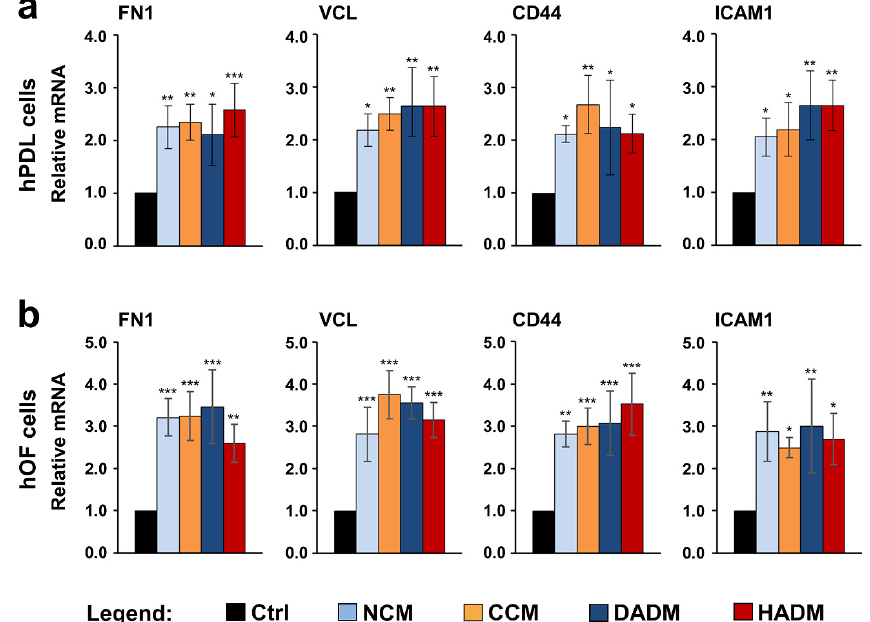
Figure 5. Increased expression of adhesive marker genes in two oral cell types grown on four different collagen matrices. hPDL ( a ) and hOF ( b ) cells were cultured on four different collagen matrices (NCM, CCM, DADM, and HADM) for 9 h followed by an extensive wash for complete removal of nonadherent cells before total RNA was extracted and analyzed for the expression of adhesive marker genes (FN1, VCL, CD44, and ICAM1) by qRT-PCR. Controls (Ctrl) represent cells of each cell type grown on cell culture plastic in the absence of a collagen matrix. Values normalized to GAPDH are expressed relative to the values of control cells. Data represent means ±SD from three independent experiments performed with three different cell donors for each of the two cell types. Significant differences to the respective controls, *** p < 0.001, ** p < 0.01, * p < 0.05.